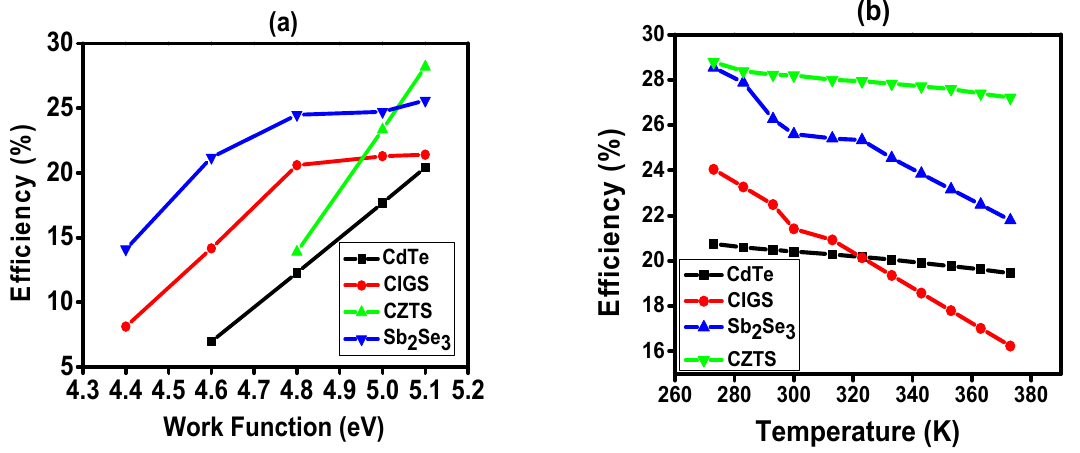
Figure 6. Effect of ( a ) back contact work function and ( b ) temperature on the efficiency of optimized structure.